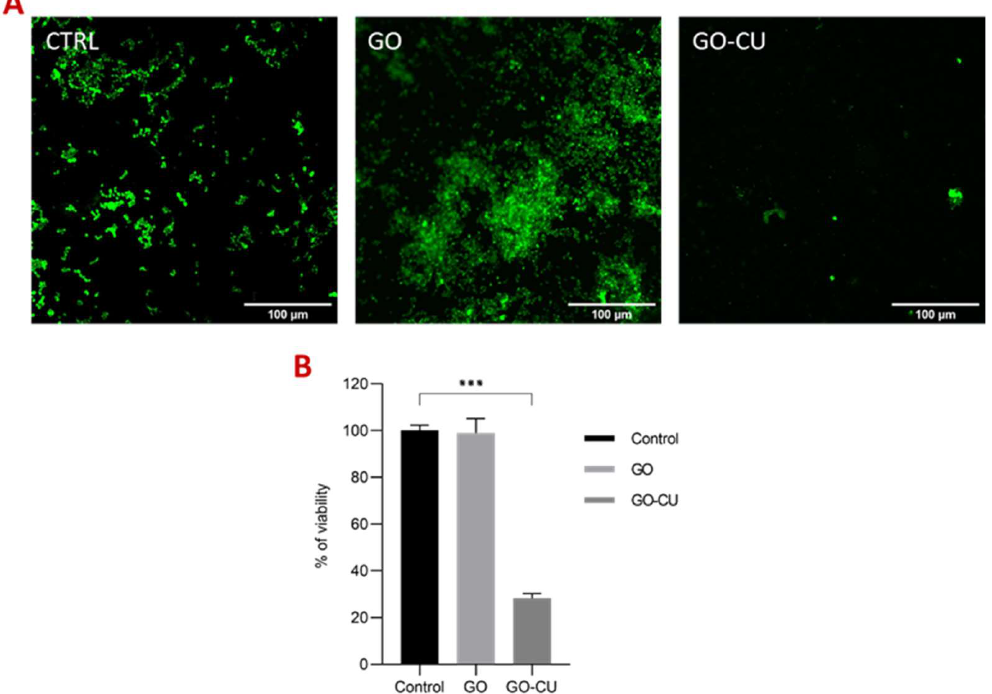
Figure 8. Fluorescein diacetate assay (FDA). ( A ) Representative confocal microscopy images of Candida biofilm grown for 72 h on plastic (CTRL), GO, and GO/CU surfaces. Images were taken at 40X magnification. The scale bar is 100 µM. ( B ). The viability (percentage of control) of biofilm-associated cells was evaluated using FDA. Fluorescent intensities were determined by ImageJ Fiji software. Standard deviations of three independent experiments are represented by error bars. p values < 0.05 were considered significant: *** < 0.001.